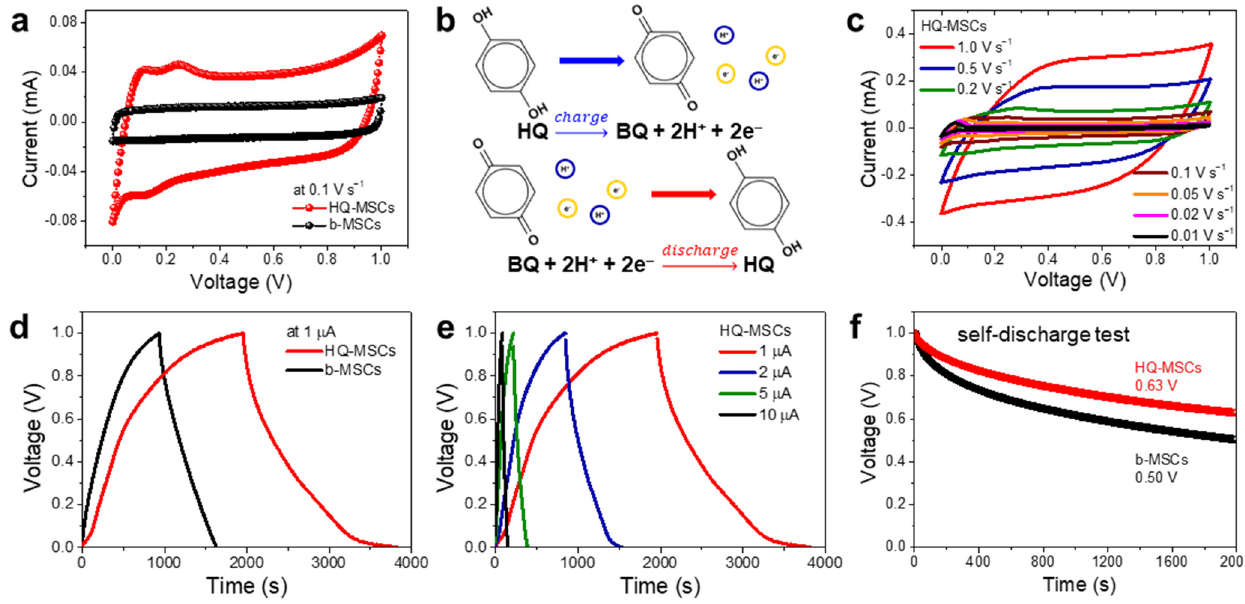
Figure 3. ( a ) Cyclic voltammetry (CV) curves of HQ-MSCs and b-MSCs at a scan rate of 0.1 V s − 1 . ( b ) Electrochemical Faradaic redox behavior mechanism between HQ and BQ. ( c ) CV curves of HQ-MSCs at different scan rates from 0.01 to 1.0 V s − 1 . ( d ) Galvanic charge/discharge graph (GCD) curves of HQ-MSCs and b-MSCs at a current 1 µA. ( e ) GCD curves of HQ-MSCs at different current ranges from 1 to 10 µA. ( f ) Self-discharging test of HQ-MSCs and b-MSCs after fully charged state.